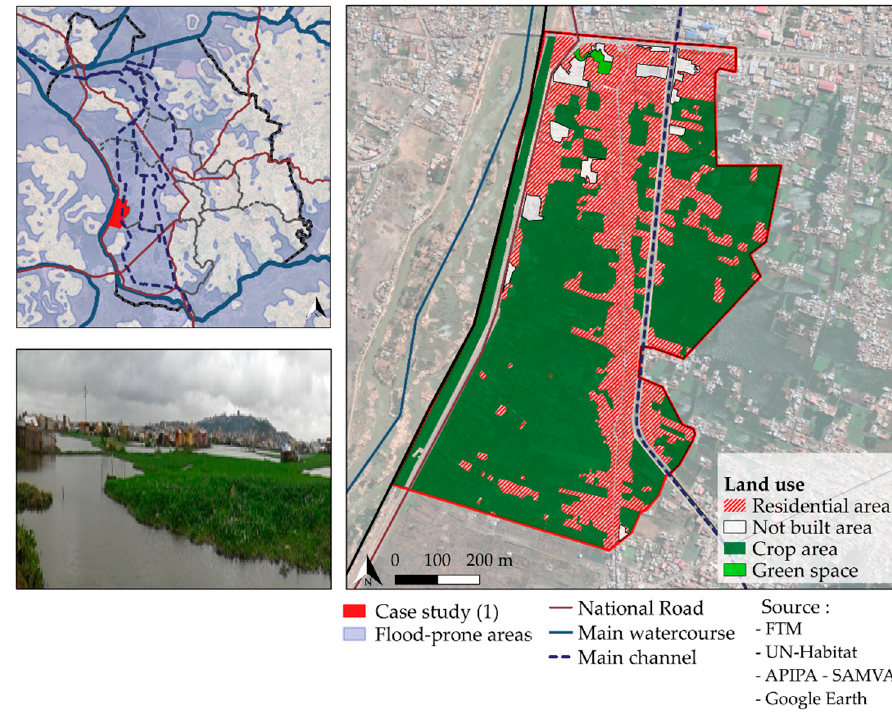
Figure 10. Map of Fokontany of Ambodirano Ampefiloha in CUA. Ambodirano Ampefiloha covers an area of 63 ha. It is crossed in the east by the GR channel, the irrigation channel of the agricultural plain, and bordered by the Ikopa in the west. It has a flat topography with areas that form basins accumulating large volumes of